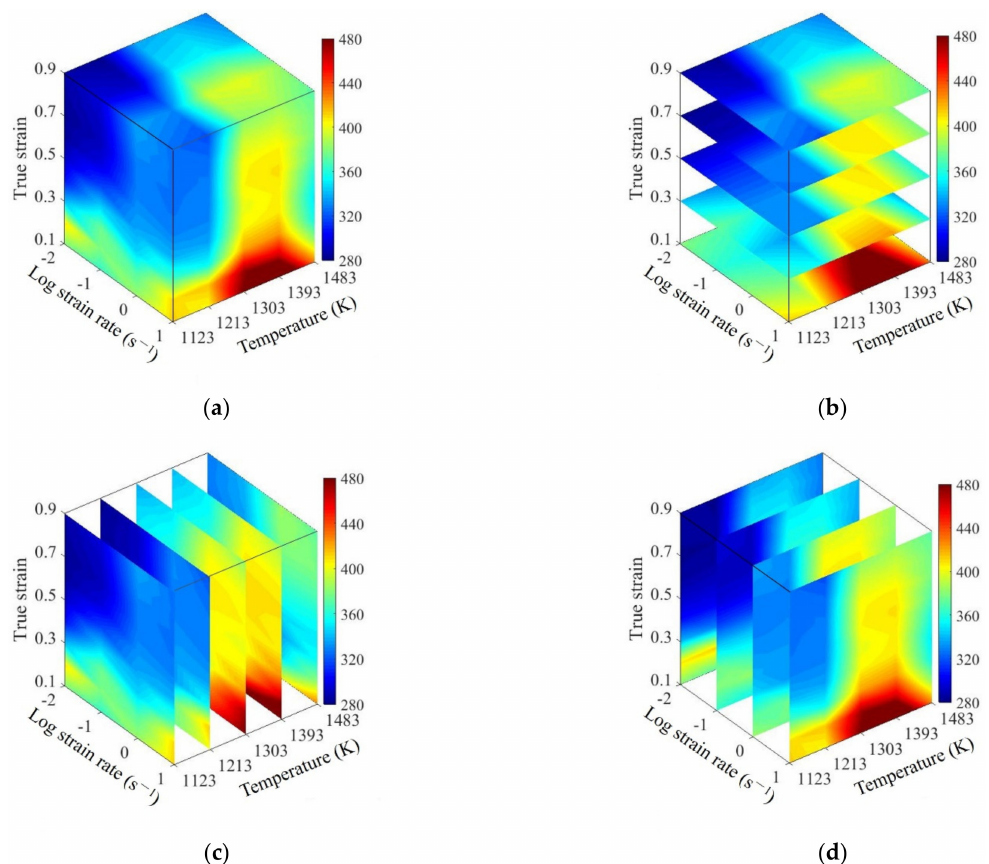
Figure 15. Linear relationships of ( a ) σ − ln 1/ T .